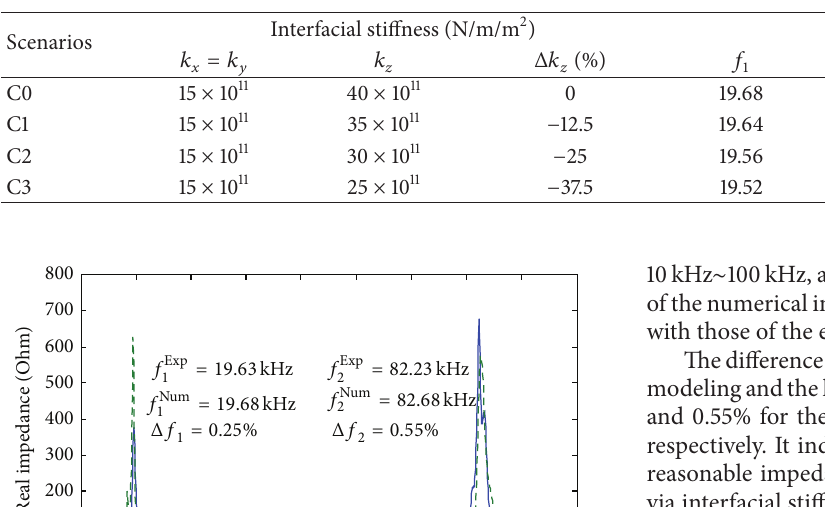
the contact stiffness is beyond the scope of this